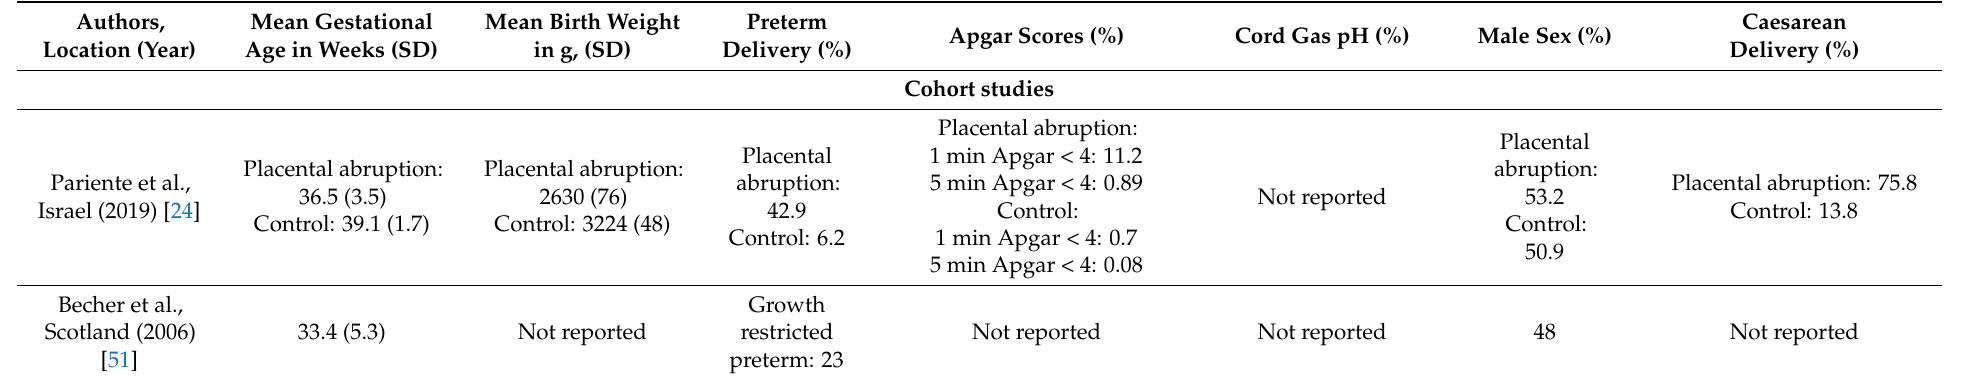
Table 3. Neonatal characteristics of the study